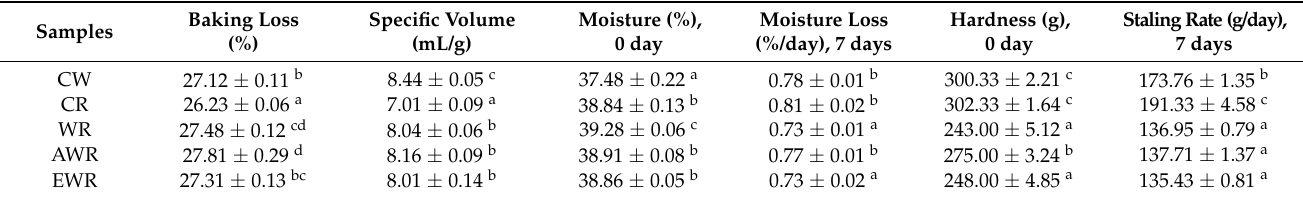
Table 3. Effects of in situ-formed EPS on baking characteristics of red bean sourdough